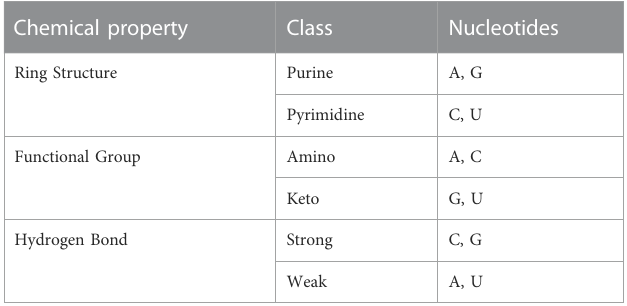
TABLE 2 Chemical structure of each nucleotide (Chen et al.,